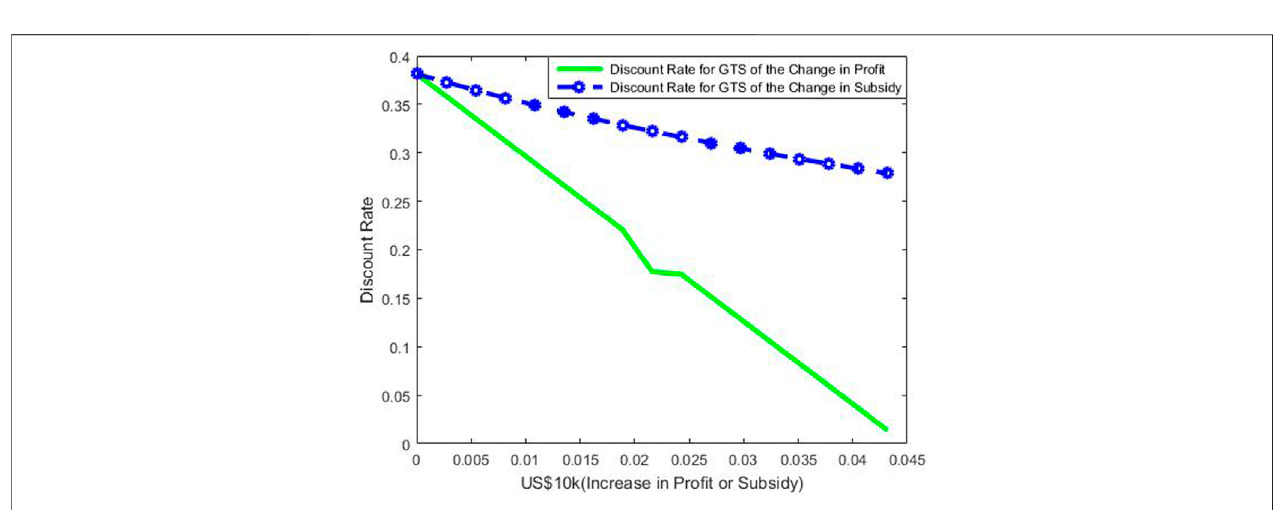
Frontiers in Energy Research |